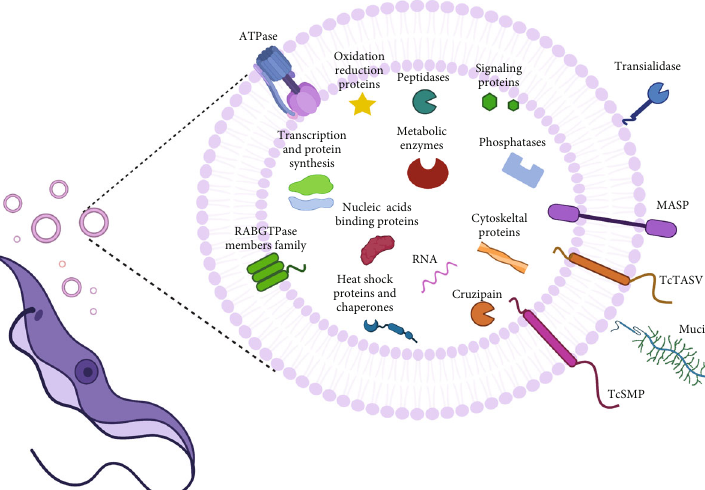
Figure 1: Schematic illustration summarizing the molecules identi fi ed in extracellular vesicles secreted by T. cruzi trypomastigotes. Several proteomic studies have identi fi ed T. cruzi virulence factors in EVs isolated from T. cruzi trypomastigotes, such as trans -sialidases, mucins, MASP proteins, the protease cruzipain, phosphatases, TcSMP, and TcTASV. Other molecules that can be found in trypomastigote EVs are signaling proteins, peptidases, oxidation/reduction proteins, ATPases, transcription and protein synthesis proteins, metabolic enzymes, cytoskeletal proteins, nucleic acid-binding proteins, heat shock proteins and chaperones, members of the RAB GTPase family and RNA, among others (created with http://BioRender.com). Table 1: Main virulence factors associated to EVs shedding by T. cruzi